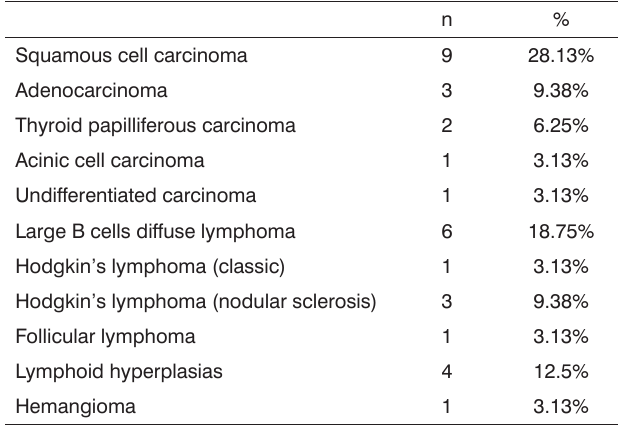
Table 4. Distribution of the use of